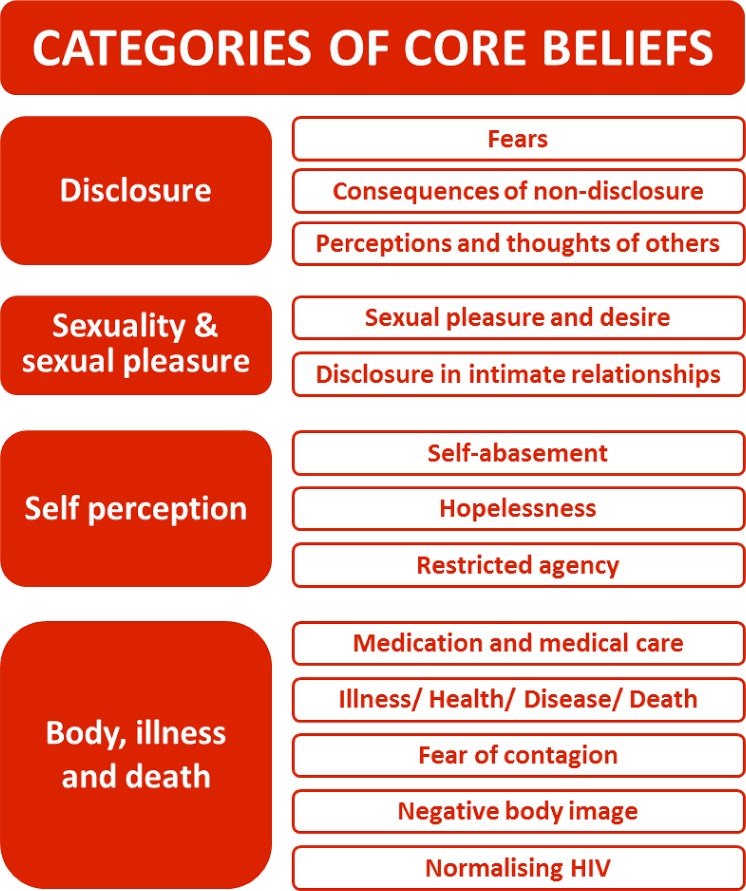
Core beliefs which contribute to HIV self-stigma.Showing core beliefs contributing to HIV self-stigma among persons living with HIV (unshaded boxes), which fall broadly across four categories (shaded boxes): Disclosure; Sexuality & Sexual Pleasure; Self-perception; and Body, illness and death. (Reproduced from Ferris France et al., 2015 [12] (Swiss Med Wkly. 2015;145:w14113) under a CC-BY License with permission from EMH Swiss Medical Publishers Ltd., original copyright 2015).